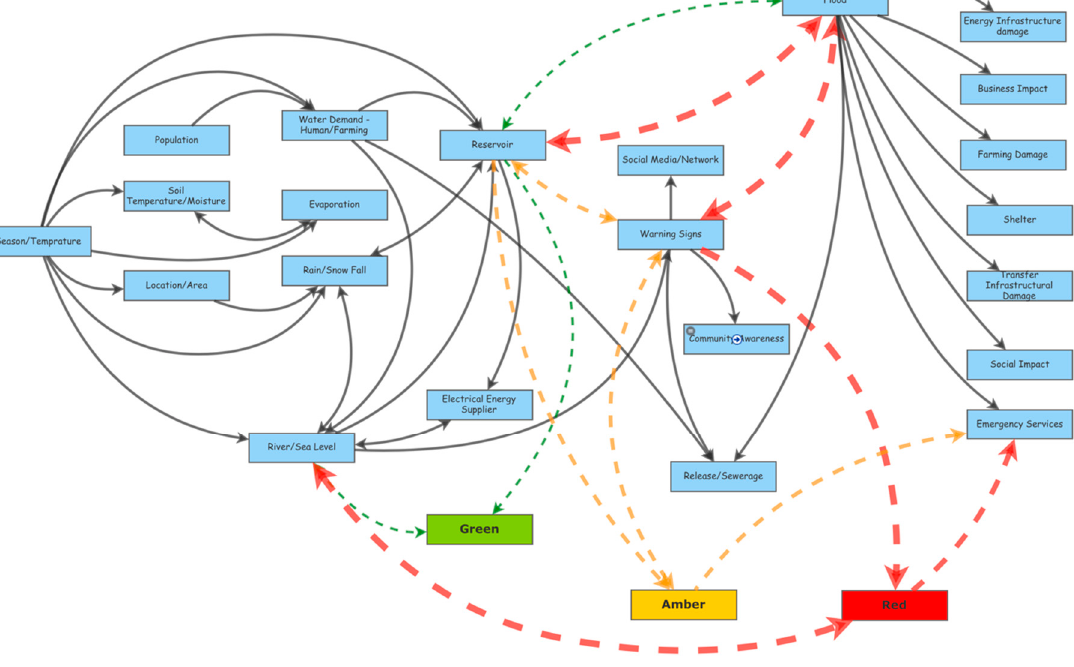
Figure 1. An overall causal loop of flood pathways. Green refers to normal conditions, amber refers to caution for a probability of flooding, and red refers to a very high risk or event of flooding.